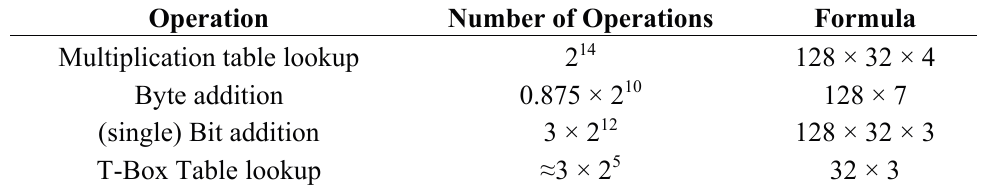
Table 1. Number of operations in the fast software implementation of white-box